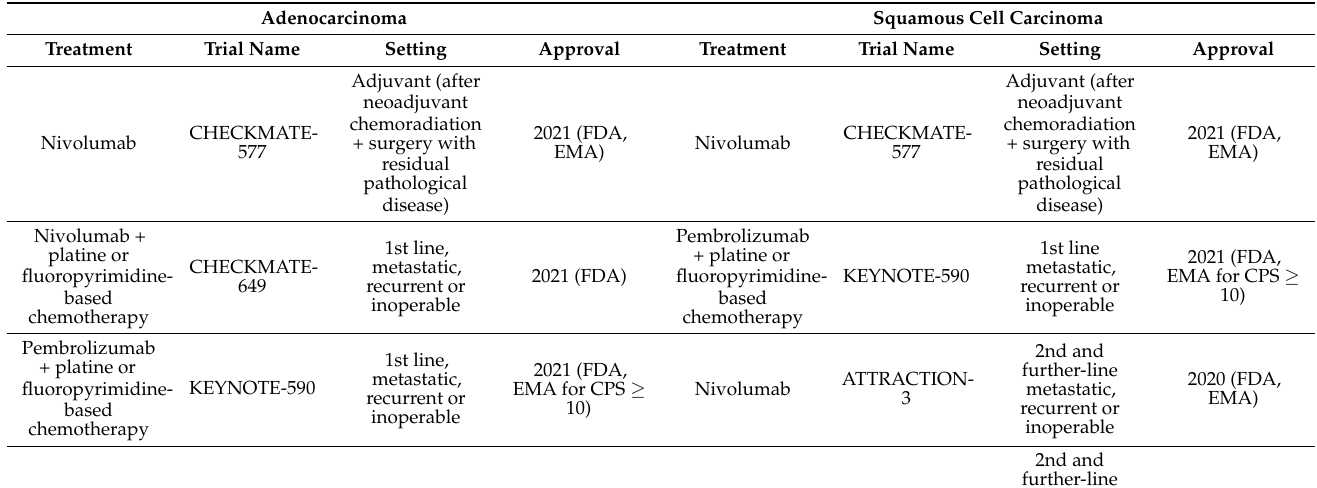
Table 3. Recent approvals of immunotherapeutic agents for esophageal